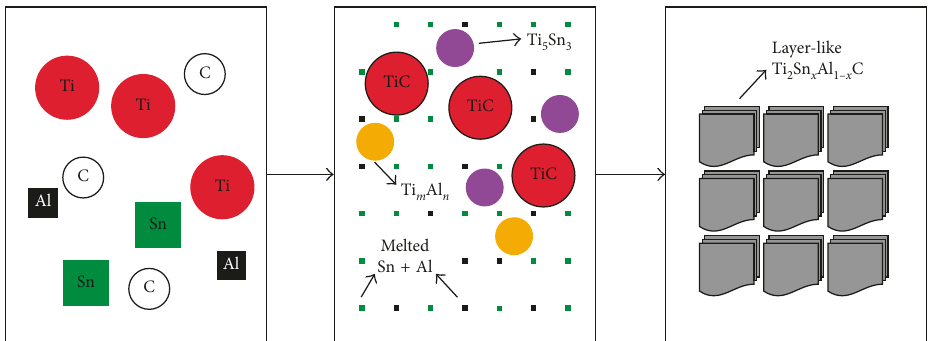
Figure 11: Schematic illustration of the route from mixing of elemental powders to the final interleaved layers of Ti Ti/Sn/Al/C powders; (b) formation of TiC, Ti 5 Sn 3 and Ti m Al n ; (c) restraint of impurity and formation of layer Ti 2 Sn x Al 1